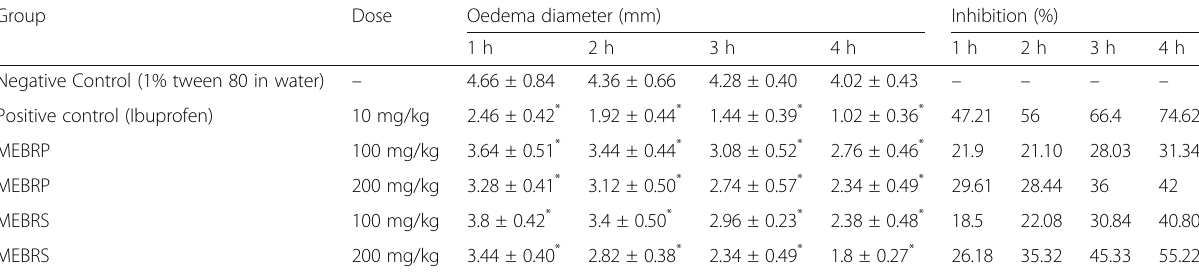
Table 2 Anti-inflammatory effects of the methanol extract of the Baccaurea ramiflora pulp and seed on carrageenan induced paw edema in mice Group Dose Oedema diameter (mm) Negative Control (1% tween 80 in water) Positive control (Ibuprofen) MEBRP MEBRP